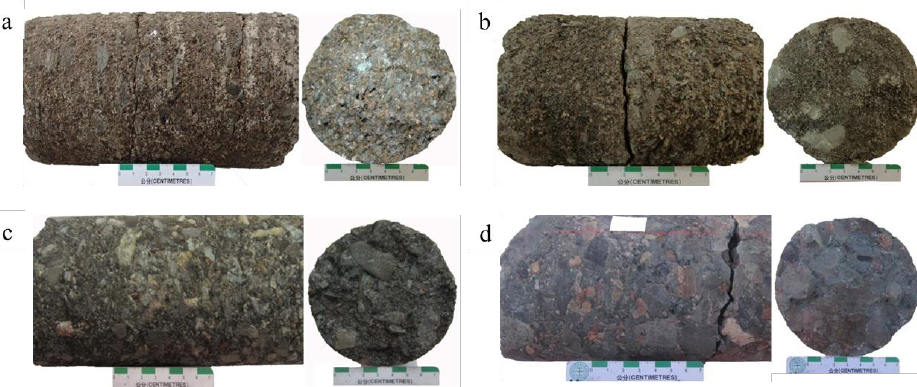
Figure 2. Typical cores of Baikouquan Formation in Mahu Sag; ( a ) Well Ma18, 3903.71–3903.92 m, gray sandy grain-supported conglomerate, oil leaching; ( b ) Well Aihu-1, 3859.67–3859.84 m, grayish-green gravelly coarse sandstone, oil leaching; ( c ) Well Ma-6, 3929.49–3929.51 m, grayish-green sandy-gravelly matrix-supported conglomerate, oil spots; ( d ) Well Aihu-013, 3859.26–3859.41 m, grey argillaceous-supported conglomerate, fluorescence.